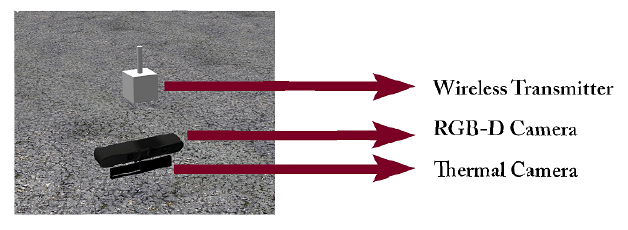
Figure 10. Floating sensor model. Table 1. RGB camera, Thermal camera, and Wireless Sensor specifications.